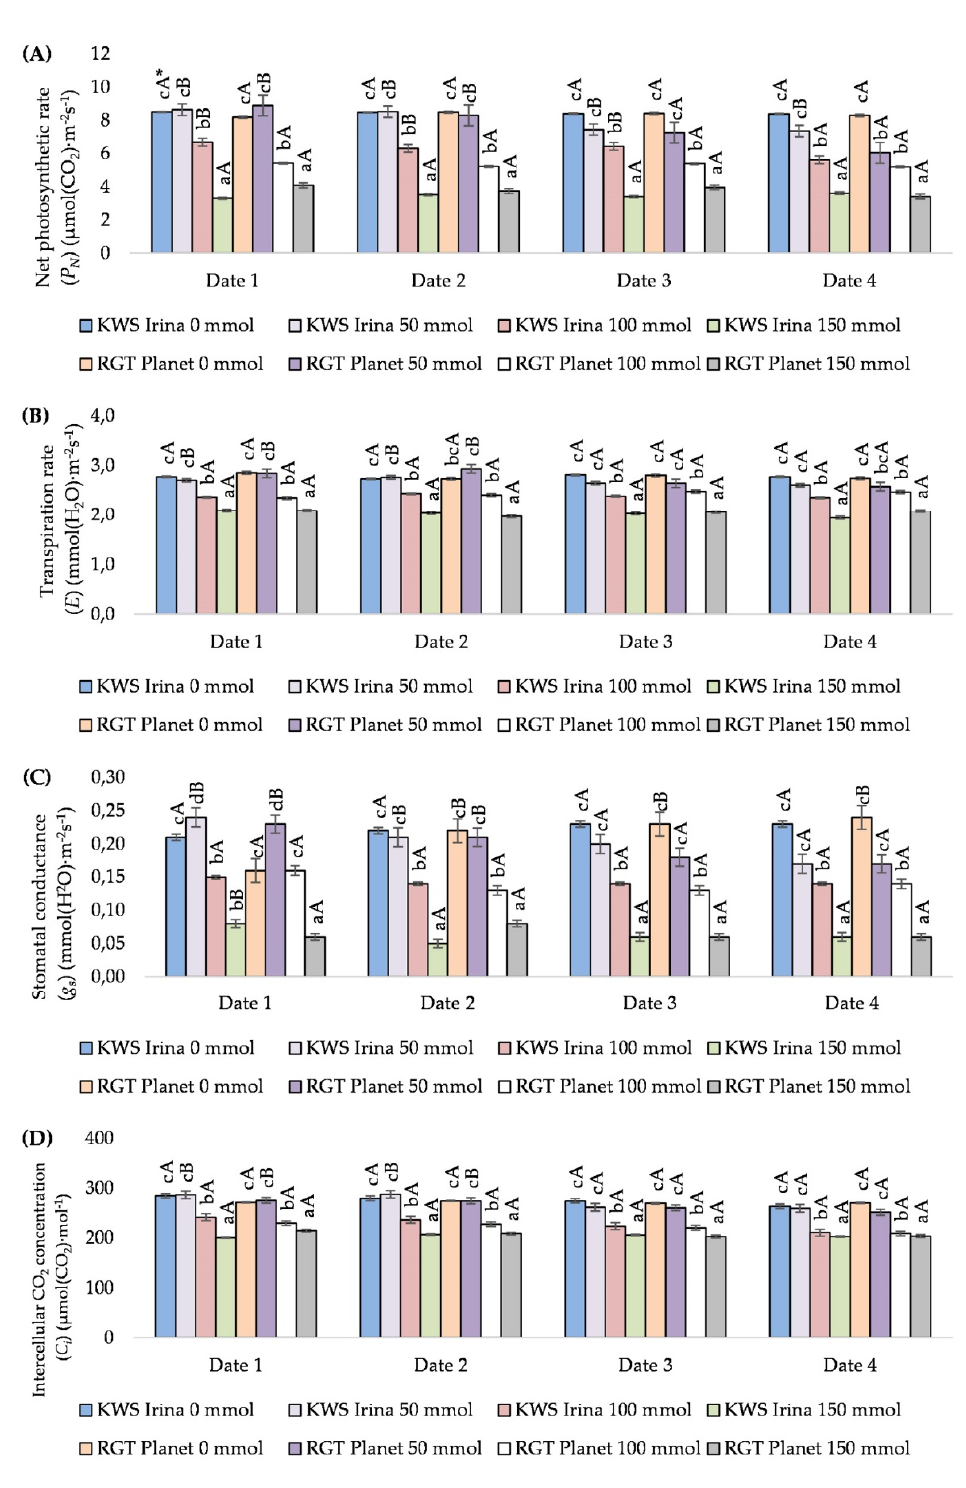
Figure 3. The effect of NaCl (mmol NaCl (dm 3 ) −1 ) concentration and measurement date on gas exchange parameters: net photosynthetic rate ( P N ) ( A ), transpiration rate ( E ) ( B ), stomatal conductance ( g s ) ( C ), and intercellular CO 2 concentration ( C i) ( D ) in the KWS Irina and RGT Planet varieties (date 1, 7 days after NaCl application; date 2, 14 days after NaCl application; date 3, 21 days after NaCl application,; date 4, 28 days after NaCl application) * Capital letters indicate significant differences between the means in the measurement dates for particular NaCl concentrations, and lower case letters indicate significant differences between the means at subsequent measurement dates ( p = 0.05).